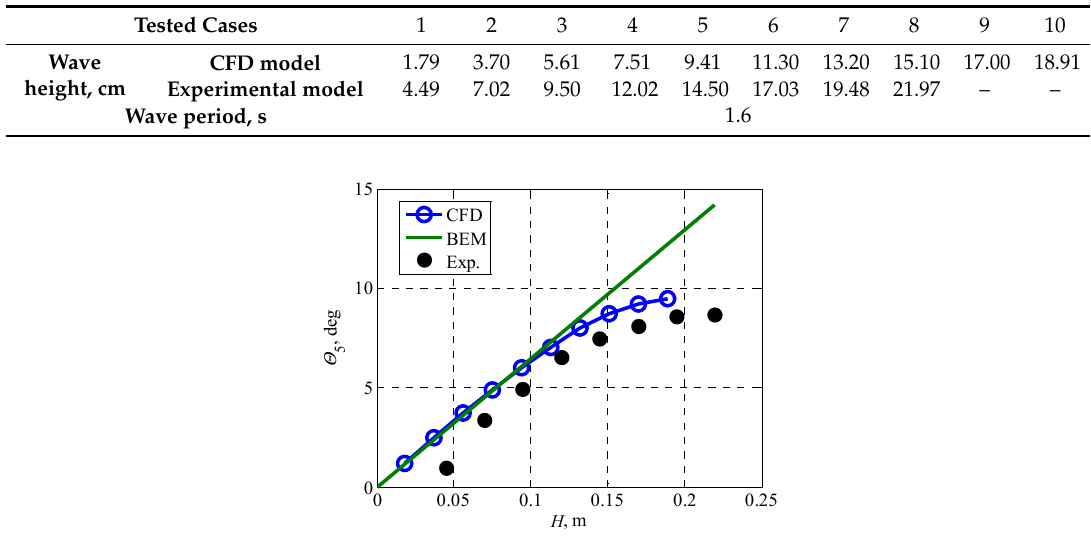
Table 2. Test cases for the comparison in different wave heights.